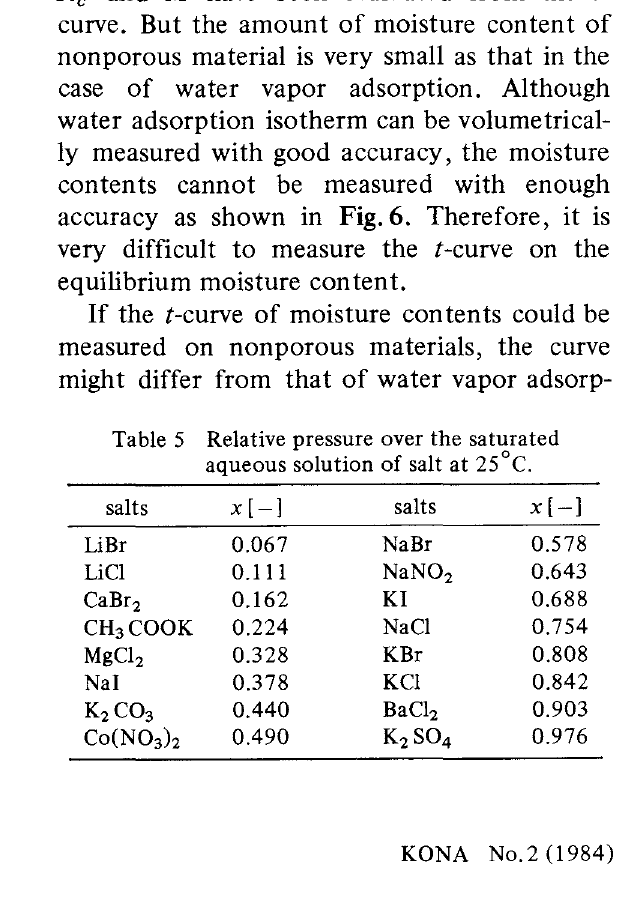
Fig. 8 Cumulative pore distribution curves obtained from adsorption